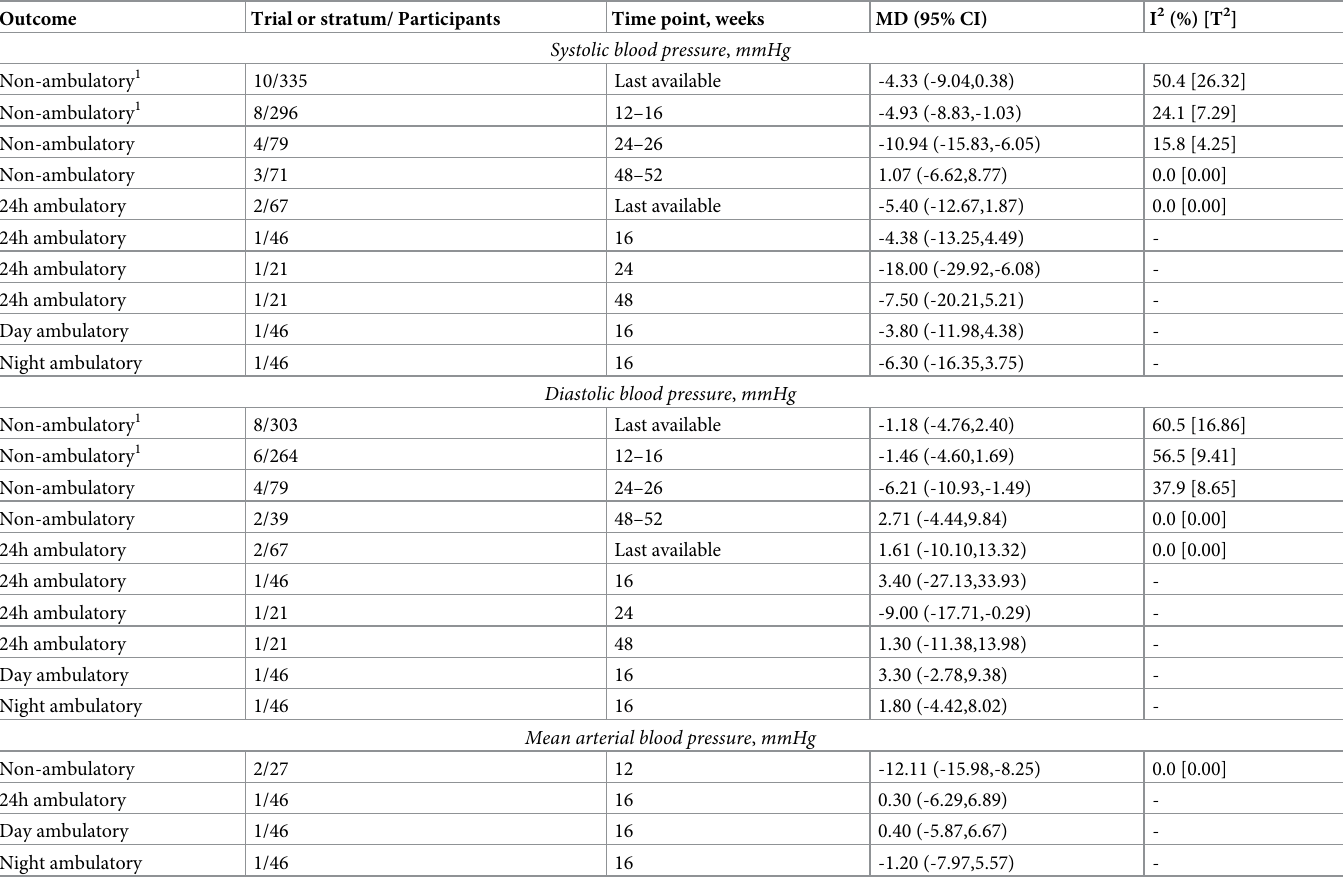
Table 4. Meta-analysis: Exercise versus no exercise on blood